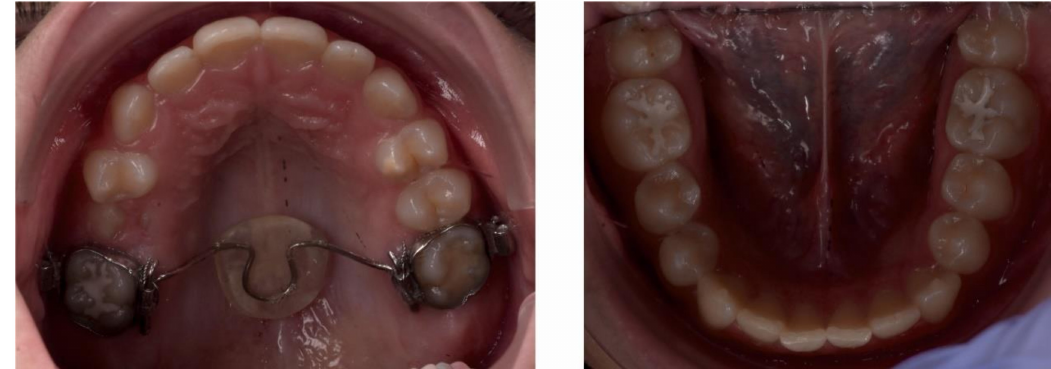
Figure 19. Intra-oral aspect after 15 months of treatment with TPA and mandibular acrylic splint—occlusal photographs.